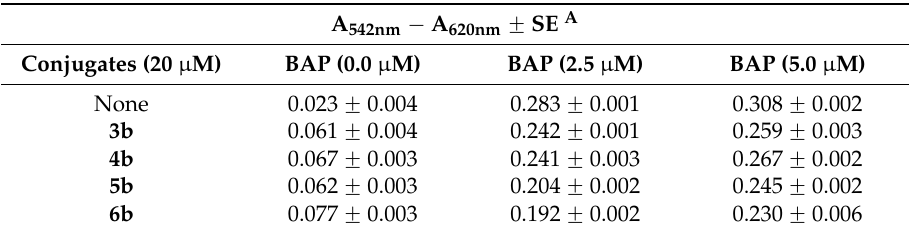
Table 2. Betacyanin level in Amaranthus seedlings cultured in the presence and absence of BAP-dexamethasone conjugates and of BAP. Betacyanin level was determined by the difference in absorbance of seedling extract at 542 and 620 nm. Each replicate combined 15